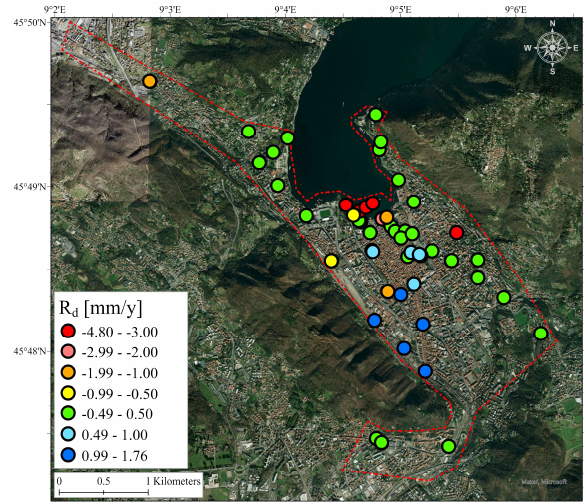
Figure 2. vertical ground deformation rate R d (in mm/year) for the period of 1990-1997 at 62 available levelling benchmarks.